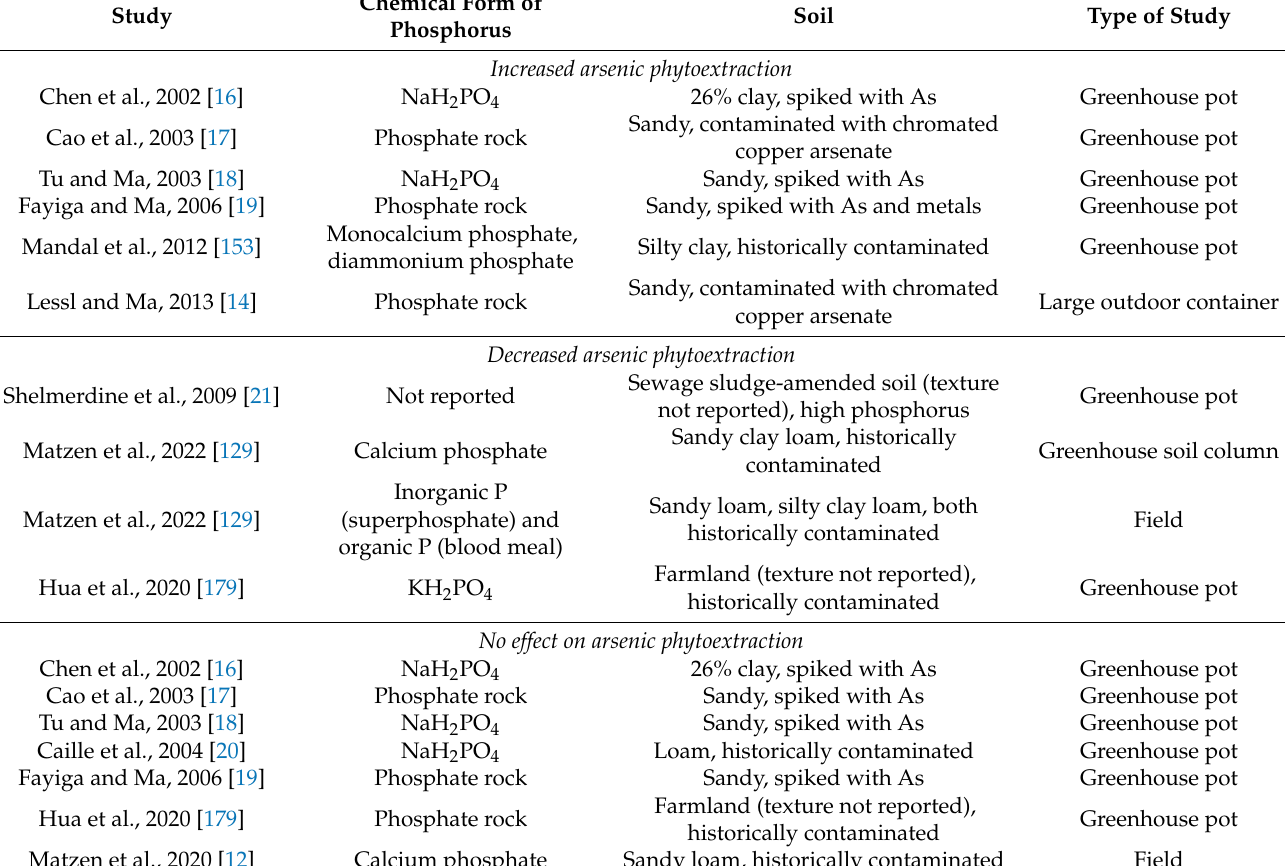
Table 2. Effects of phosphorus on arsenic